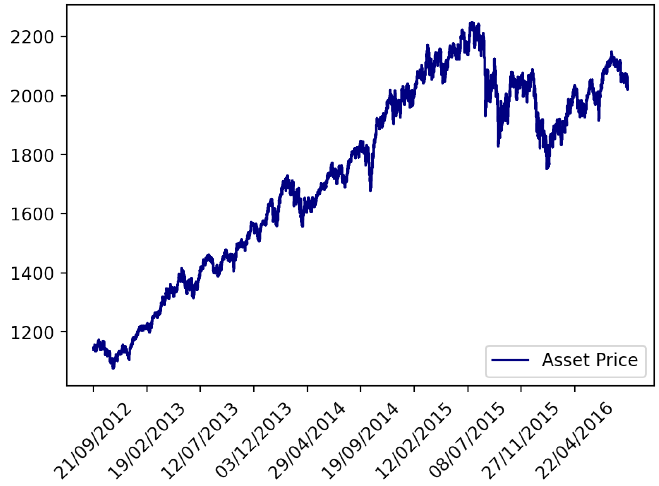
Figure 2. Asset prices from 2012 to